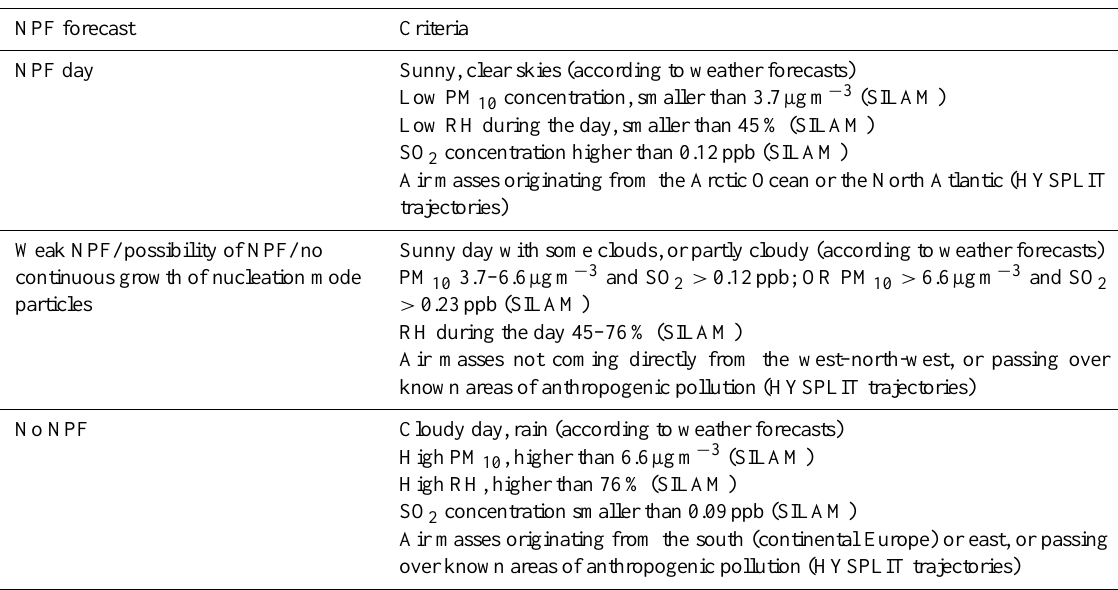
Figure 2. Overview of the meteorological parameters, trace gas concentrations and particle size distributions during the campaign 3 May– 11 June 2013. Table 2. Criteria for the NPF forecasts (the source for each data is shown in parentheses). All the criteria within the category must be fulfilled; i.e. the individual criteria are combined with logical operator